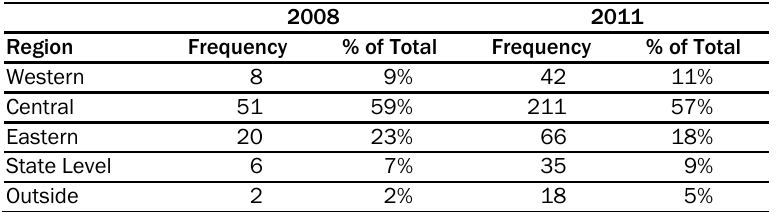
Table 2. Comparison of Collaborating Organizations by North Carolina Region, 2008 and